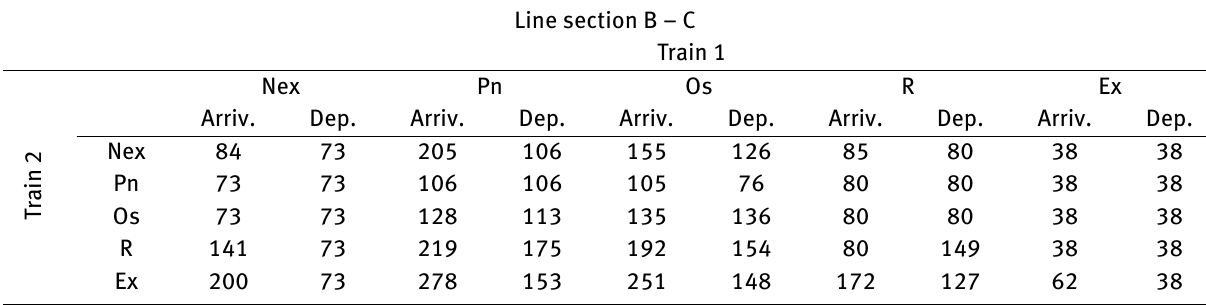
Line section B – C